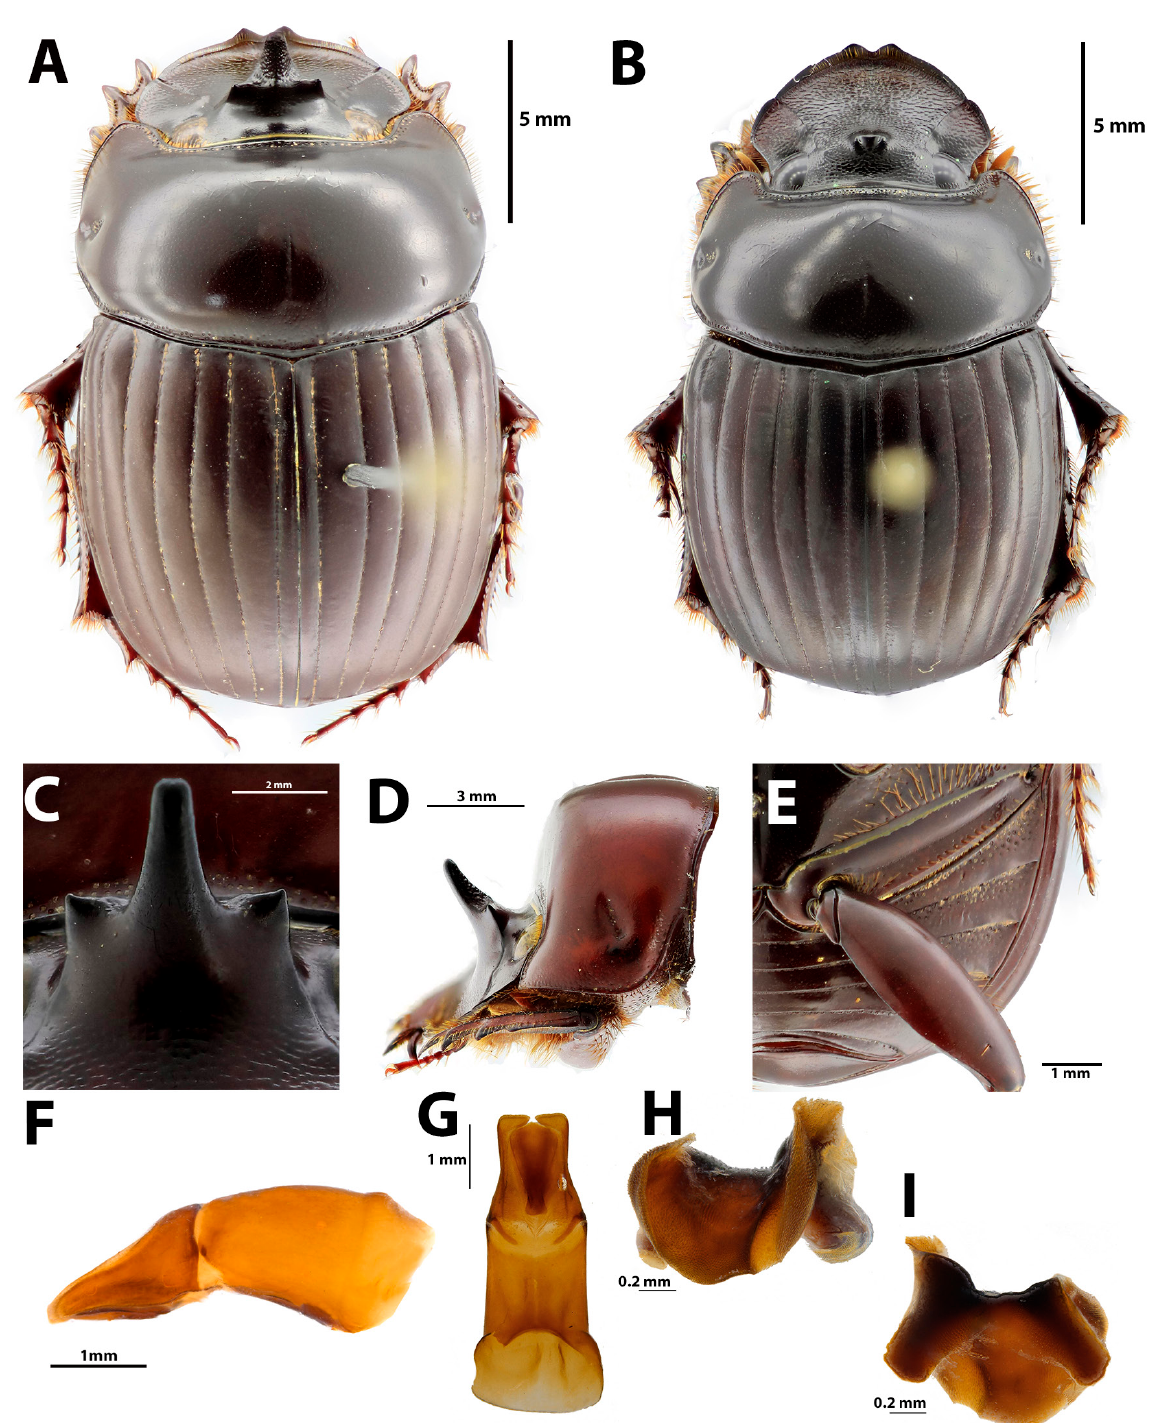
Fig. 17. Dichotomius tristis (Luederwaldt, 1923). A–B . Dorsal habitus. A . ♂. B . ♀. C . Anterior view of the cephalic carina, medial tubercle apically truncate. D . Lateral view of the pronotum, anterior declivity truncate. E . Ventral view of the metacoxa, displaying a single row of punctures on the posterior margin. F . Lateral view of the aedeagus. G . Ventral view of the aedeagus. H–I . Lamella